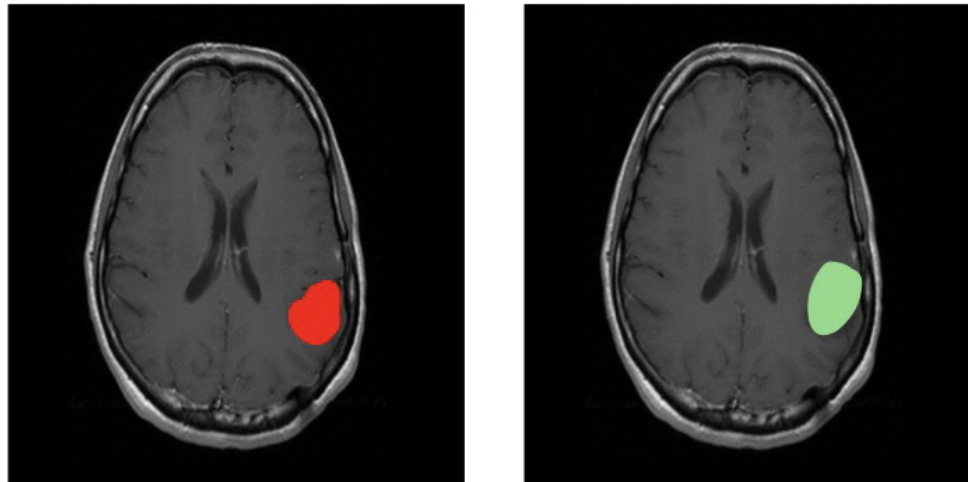
Figure 9. Experimental assessment, comparisons between the two segmentation methodologies. The left side shows the proposed method, the right side shows Slicer